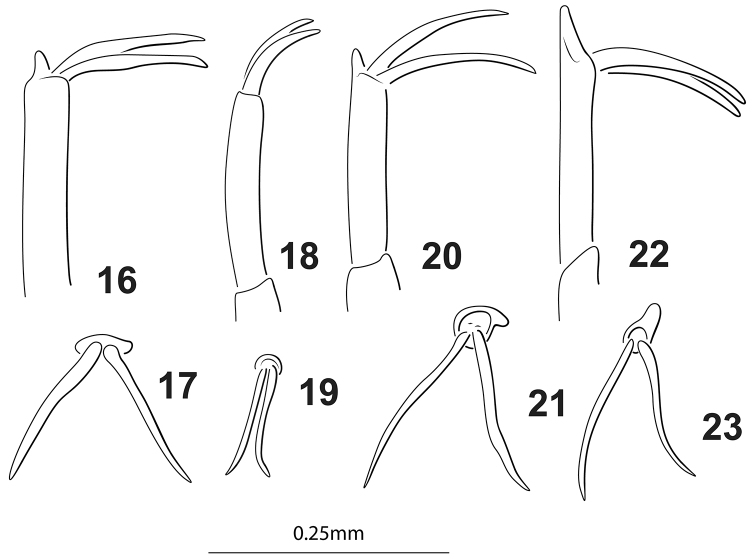
Agaporomorphus species, male mesotarsomere V and mesotarsal claws. 16, 17A.
tortus16 anterior aspect 17 oblique lateral aspect 18, 19A.
grandisinuatus18 anterior aspect 19 oblique lateral aspect 20, 21A.
mecolobus20 anterior aspect 21 oblique lateral aspect 22, 23A.
dolichodactylus22 anterior aspect 23 oblique lateral aspect.